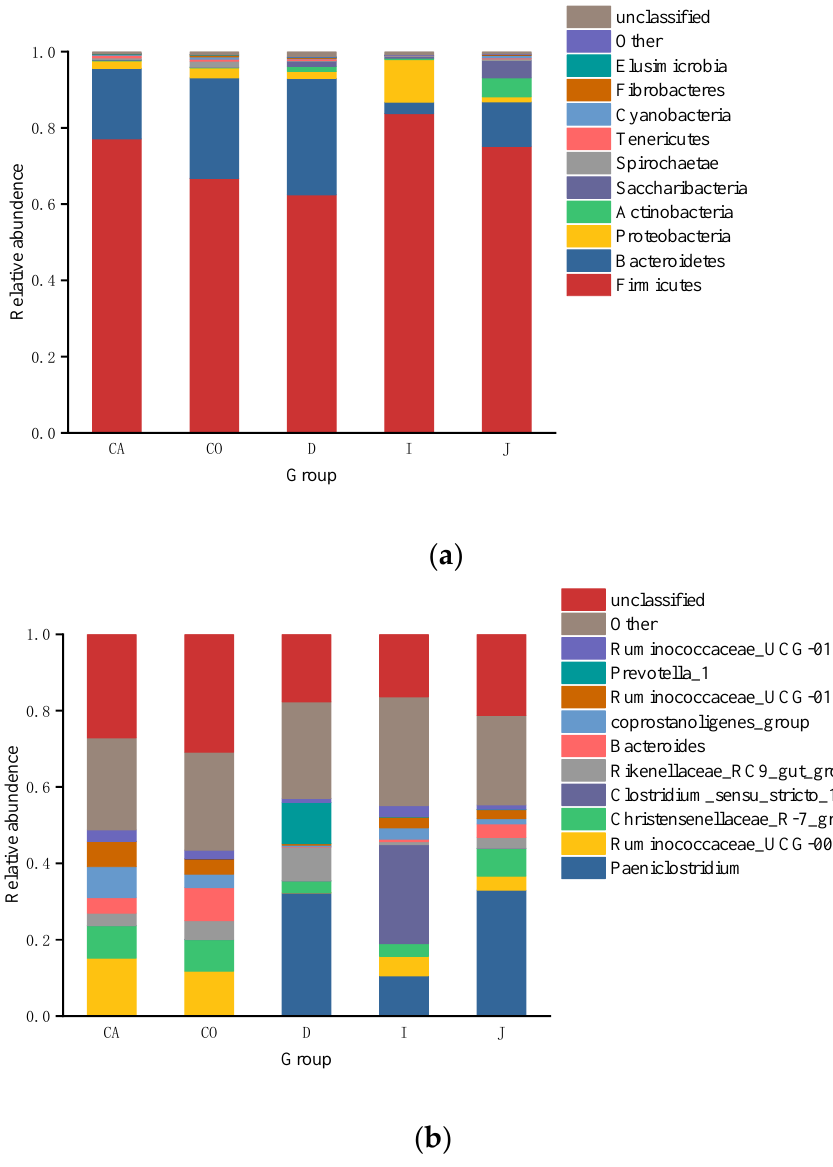
Figure 4. Relative abundance of microorganisms in each group. Both ( a ) and ( b ) show the relative abundance of intestinal microorganisms in each group in the contexts of phylum and genus.